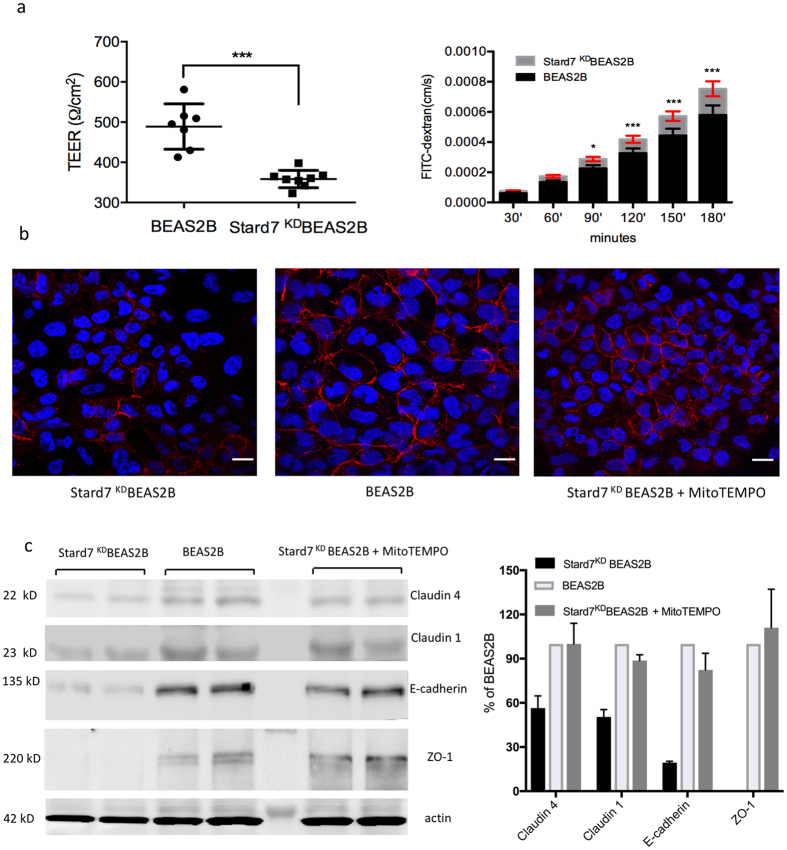
Stard7 deficiency increases epithelial barrier permeability.(a) The effect of Stard7 deficiency on BEAS-2B cell monolayer integrity was assessed by measuring transepithelial electrical resistance (TEER, left panel). The effect of Stard7 deficiency on the transepithelial permeability was determined by measuring apical to basolateral diffusion of FITC-dextran at the indicated time points (right panel). Data are expressed as mean ± SEM, n = 3; *p < 0.05, ***p < 0.0001, BEAS-2B cells vs. Stard7KDBEAS-2B cells. (b) Expression of the adherens junction protein E-cadherin was assessed by immunofluorescent staining of BEAS-2B cells and Stard7KDBEAS-2B cells cultured in the presence or absence of MitoTEMPO. Scale bars = 50 μM. (c) Apical junction protein expression was assessed in BEAS-2B cells and Stard7KDBEAS-2B cells, cultured in the presence or absence of MitoTEMPO. Equal numbers of cells from each experimental group were aliquoted in duplicate, cultured for 48 h, and 20 μg protein from each cell lysate analyzed by SDS-PAGE/western blotting (left panel). Protein bands were quantitated by densitometry, the data normalized to actin, and mean values expressed as percent of BEAS-2B control cells (right panel).